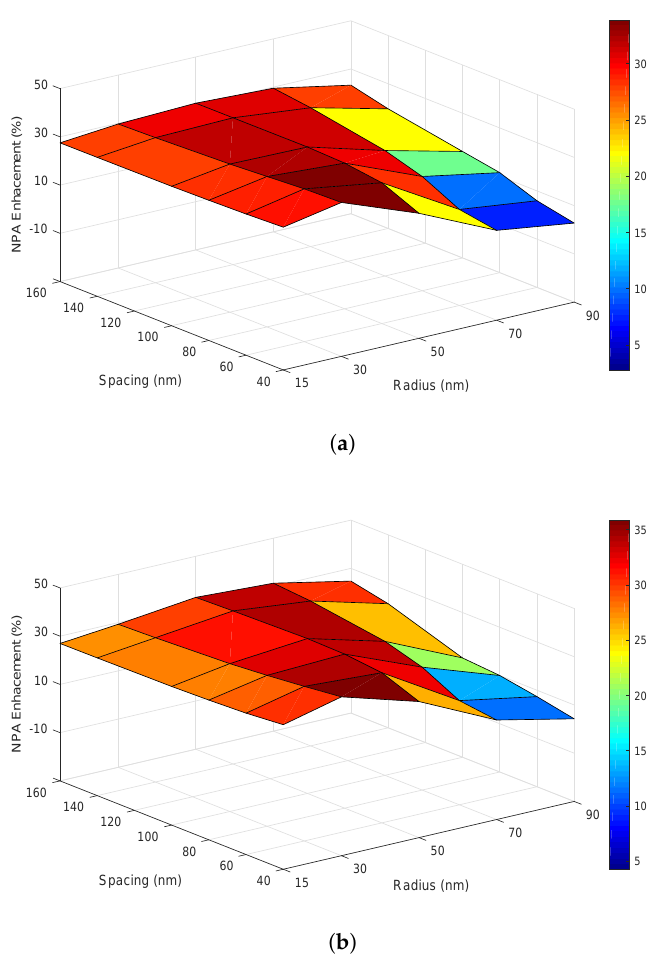
Figure 2. NPA Enhancement (%) in silicon as a function of radius and inter particle spacing of ( a ) Ag Nanoparticle ( b ) Al Nanoparticle.